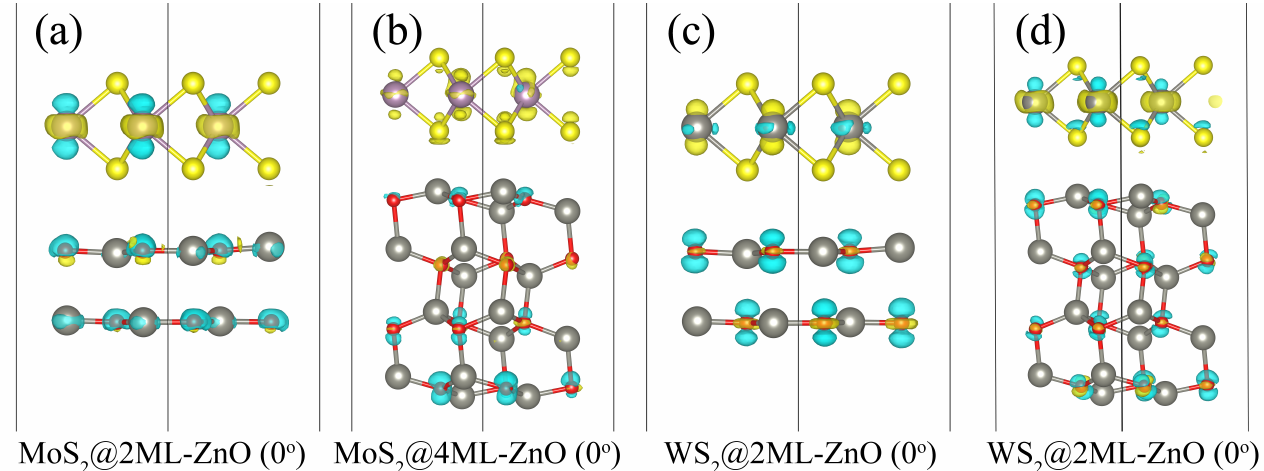
Figure 11. Side views of the differential total charge density maps calculated for MoS 2 @ZnO ( a , b ) and WS 2 @ZnO ( c , d ). The yellow and cyan colors indicate accumulated and depleted charge density, respectively. The isosurface increment value is 0.01 bohr − 3